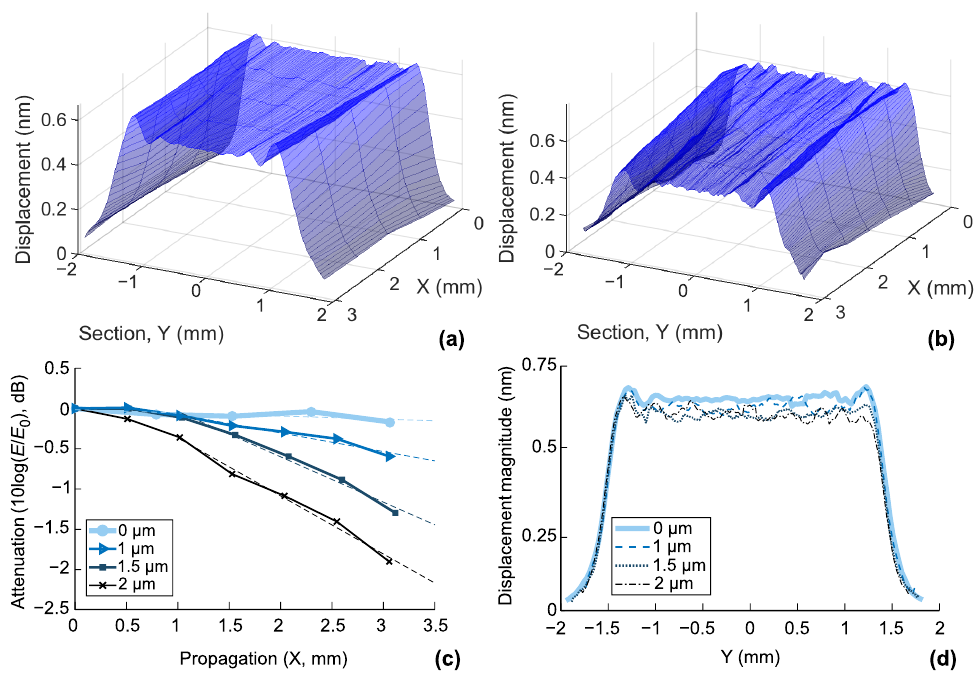
Figure 4. Measurement of SAW attenuation with LDV: ( a , b ) 3D profiles of SAW displacement cross- section distribution for the non-covered and the sensor covered with 2 µm thick parylene layer, respectively; ( c ) profile of energy decaying during propagation; ( d ) energy distribution at the emitting point (corresponding to X = 0 mm in ( a , b